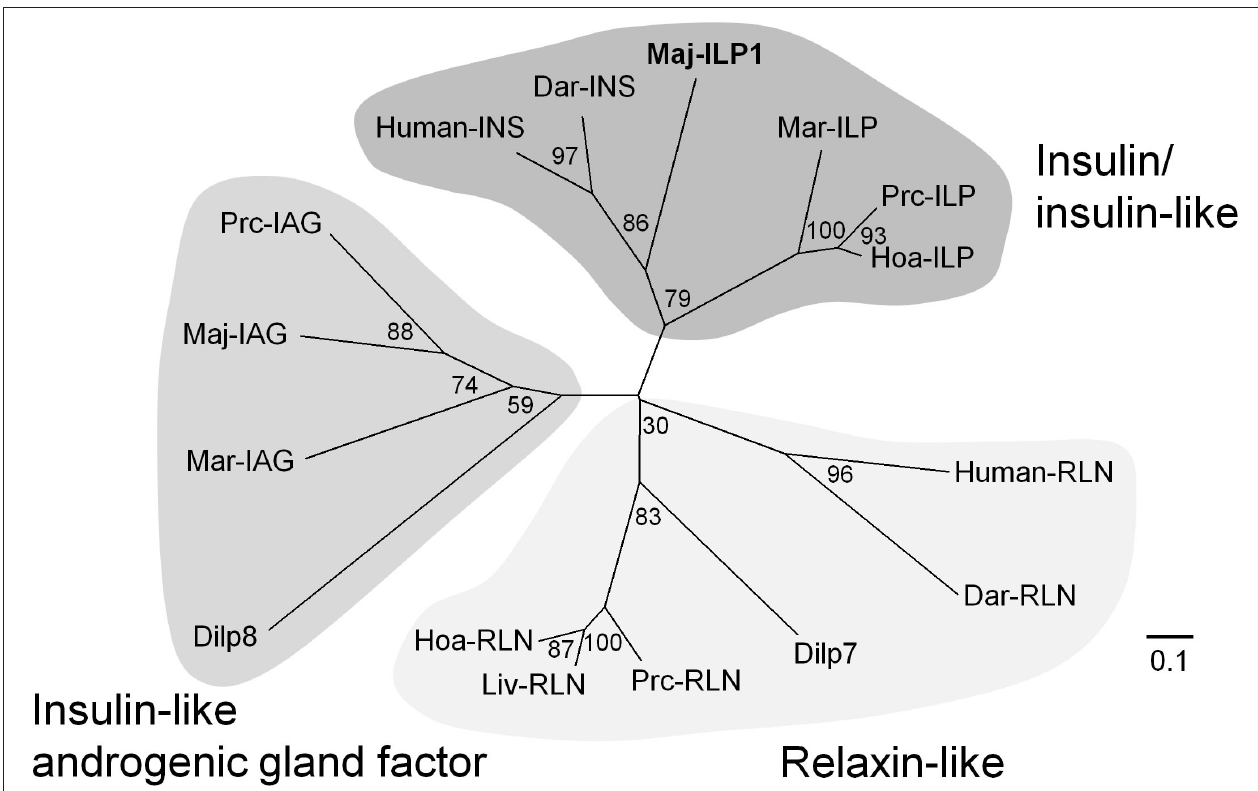
FIGURE 3 | Molecular phylogenetic tree of insulin-family peptides. This phylogenetic tree was constructed by the neighbor-joining method with computation of the evolutionary distances using Poisson correction. Values at the nodes represent the percentage of 1,000 bootstrap replicates. The scale bar shows the number of substitutions per site. Accession numbers of cDNA sequences used are as follows: human-INS, BC005255; human-RLN, A06846; Dar-INS, Dar-RLN, JN215212; Dilp7, NP_570070; Dilp8, NP_648949; Maj-IAG, BAK20460. The other sequences have been cited from a recent report